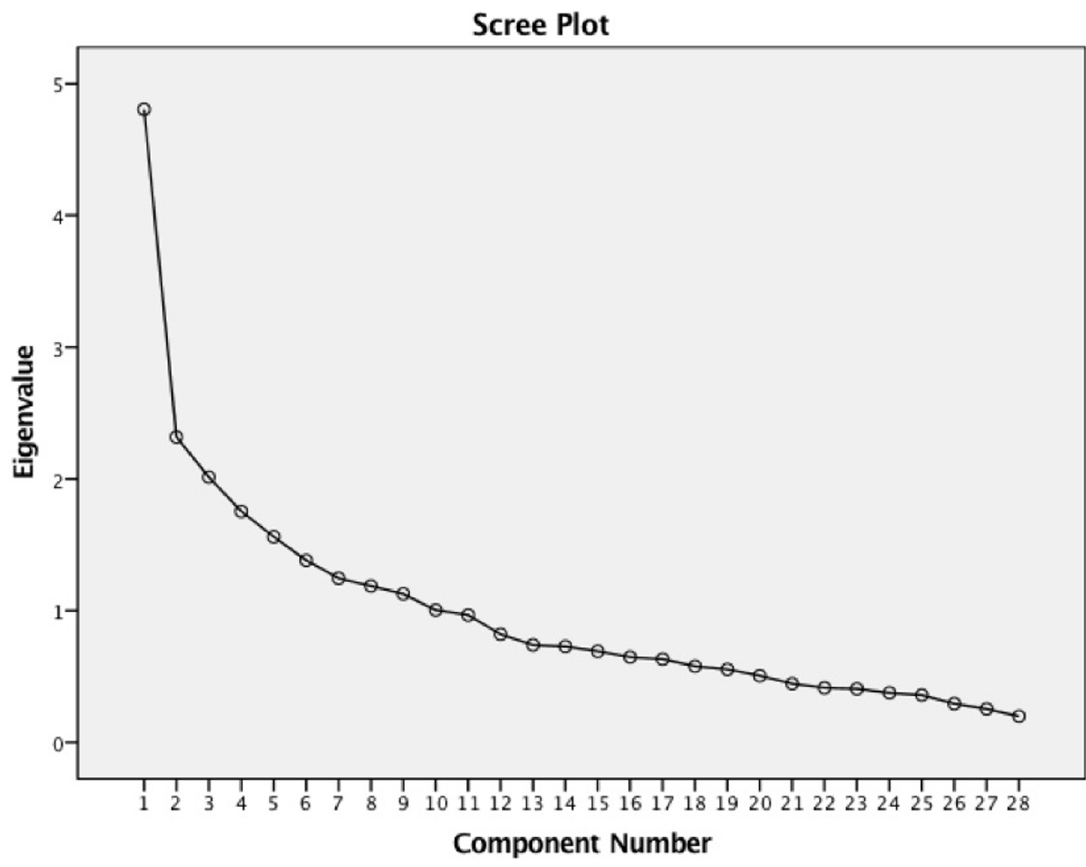
Fig 1. Scree plot showing the eigenvalues of extracted components of the SBQ data.